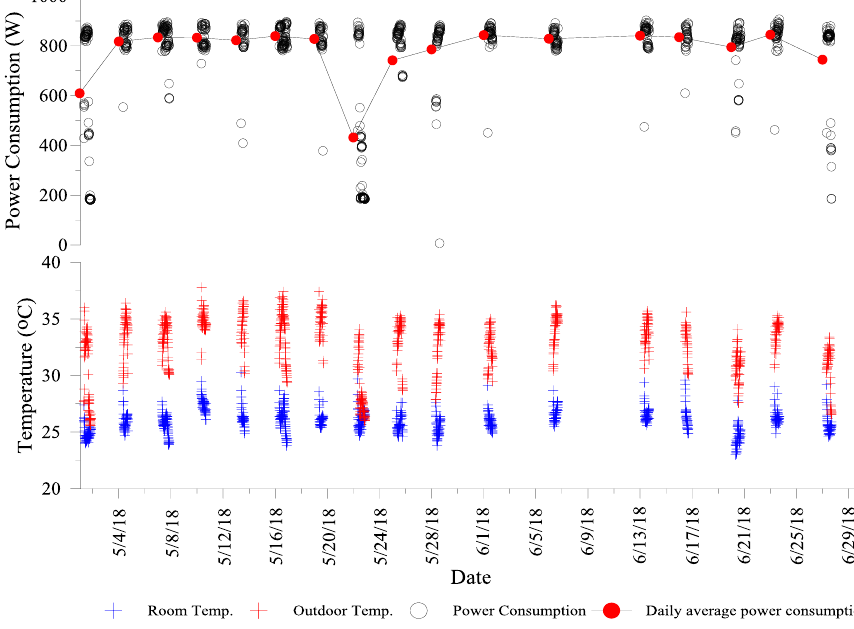
Figure 13. Performance of the ASHP (10-min interval data during the operational period).